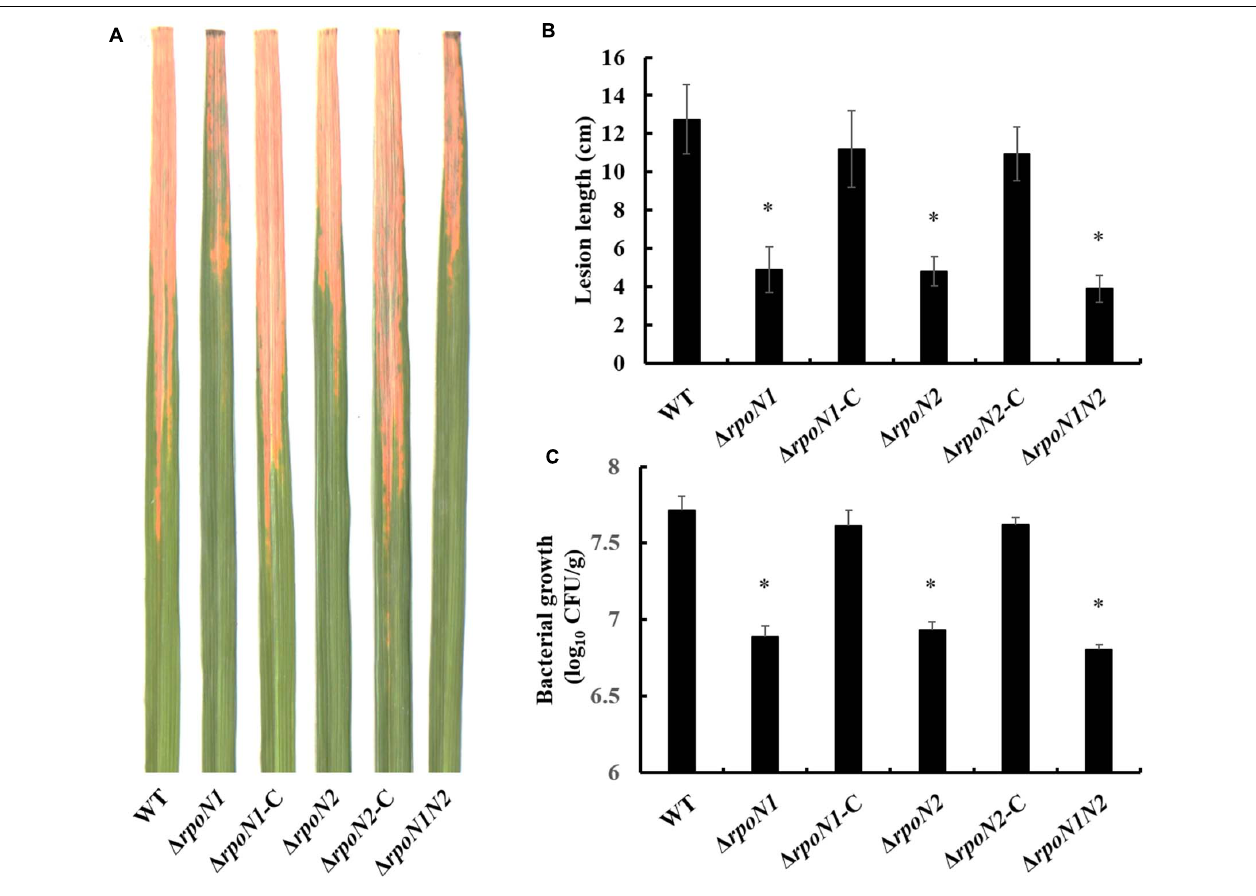
FIGURE 2 | RpoN1 and RpoN2 positively regulate the virulence in Xoo . (A) Disease symptoms, (B) disease lesion lengths, and (C) bacterial population. Disease symptoms and lesion lengths were photographed and measured in the second week after inoculation. For bacterial population assay, three leaves were collected and mixed as one sample for each strain. The experiments were performed three times independently. Asterisks indicate significant differences between wild-type and mutants ( P -value < 0.05) (Student’s t